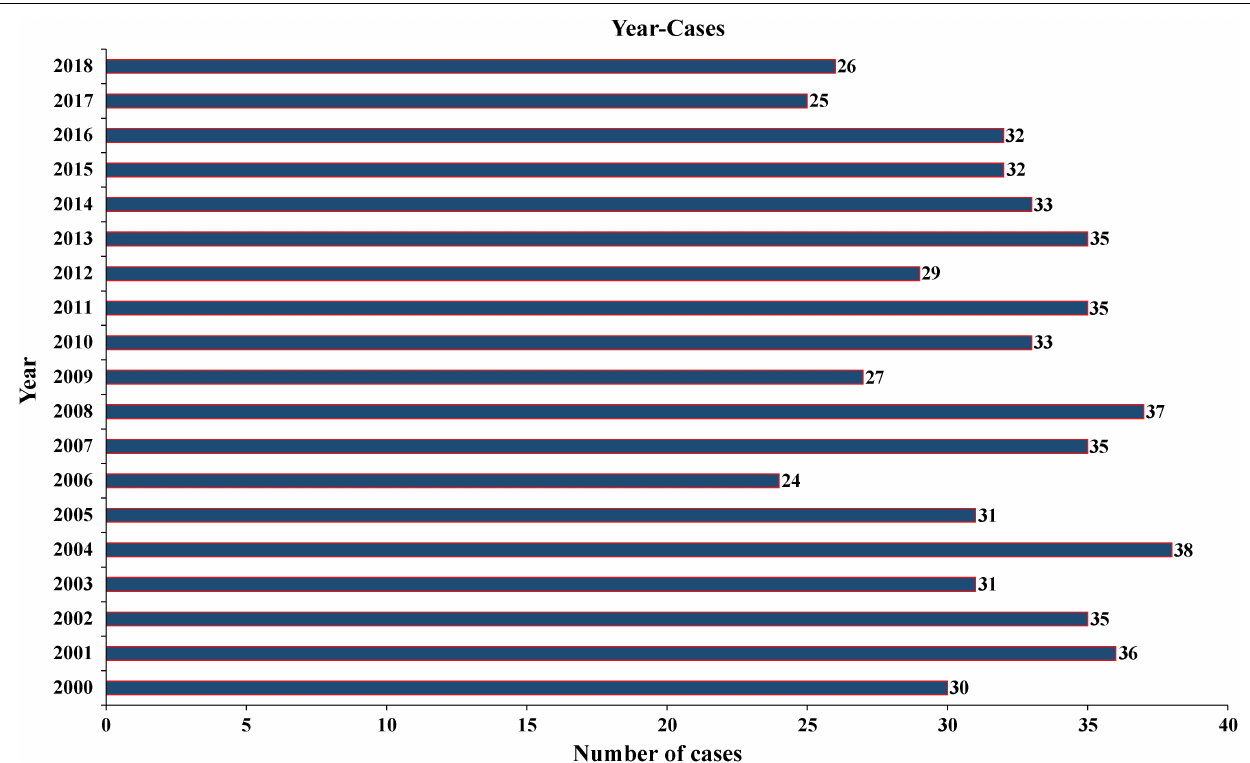
FIGURE 1 | Annual number of PC cases recorded in 18 registries of the United States from 2001 to 2018. PC, parathyroid carcinoma.